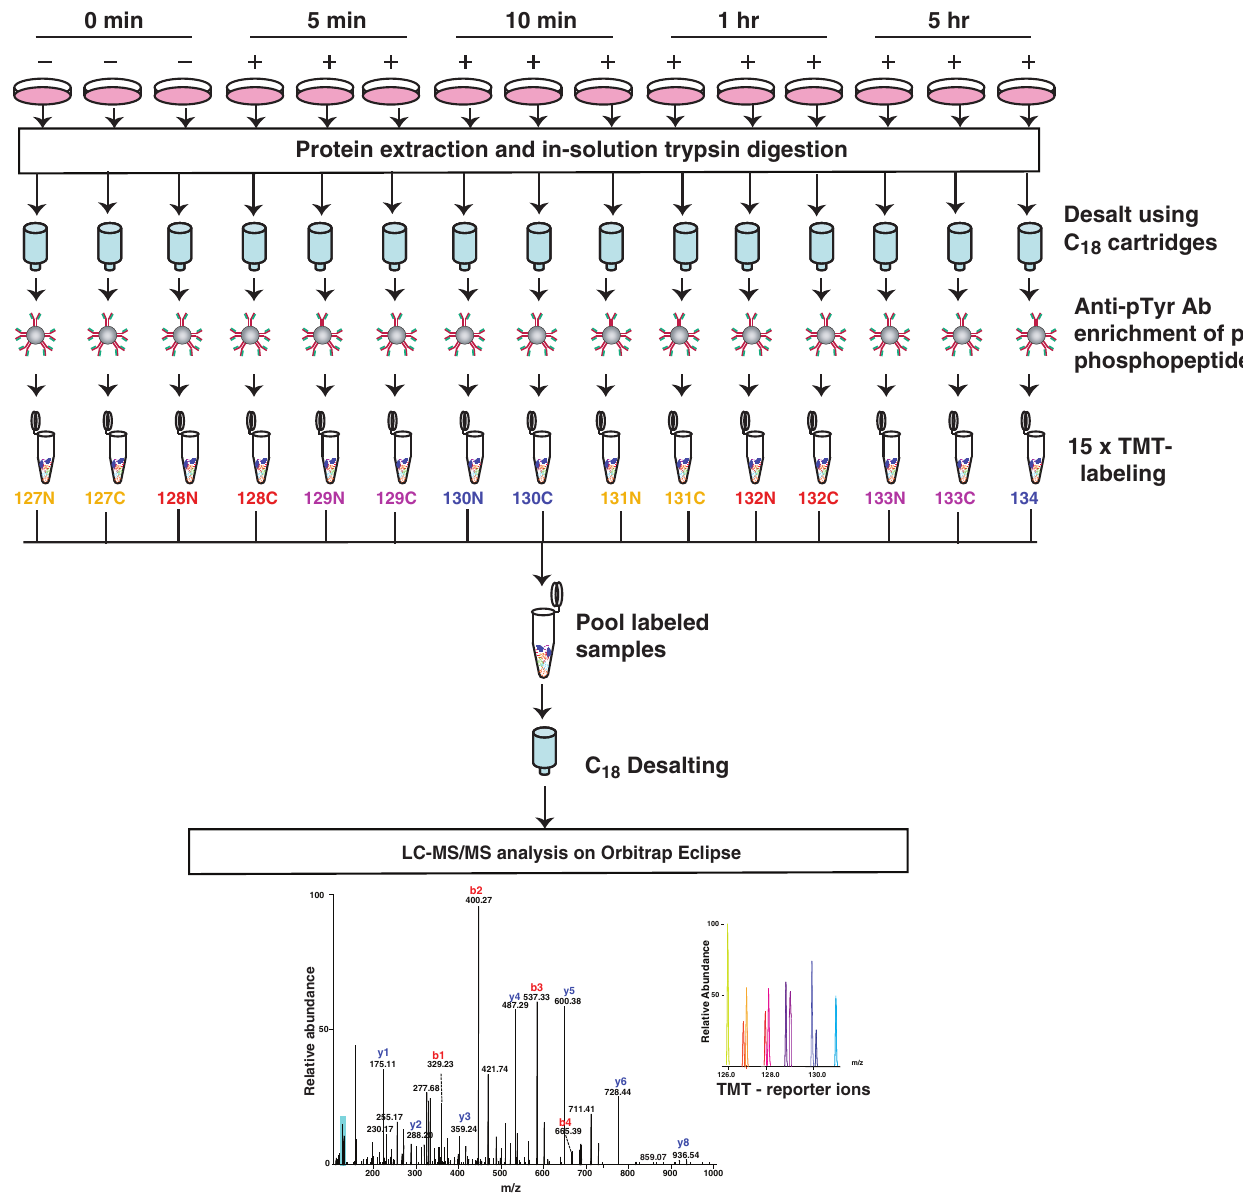
Figure 2. A schematic depicting the strategy used for temporal quantitative phosphotyrosine proteomic profiling of GAS6-treated MDA-MB-231 cells. All experiments were performed in triplicate. Cells were serum starved for 18 h and treated with 400 ng/mL GAS6 for 5 min, 10 min, 1 h or 5 h. After the GAS6 treatment, cells were harvested and lysed in 8 M urea buffer, followed by trypsin digestion and desalting. Tyrosine phosphorylated peptides were enriched with anti-pTyr antibody (pY1000). Enriched peptides were labeled with the TMTpro kit and analyzed by Orbitrap